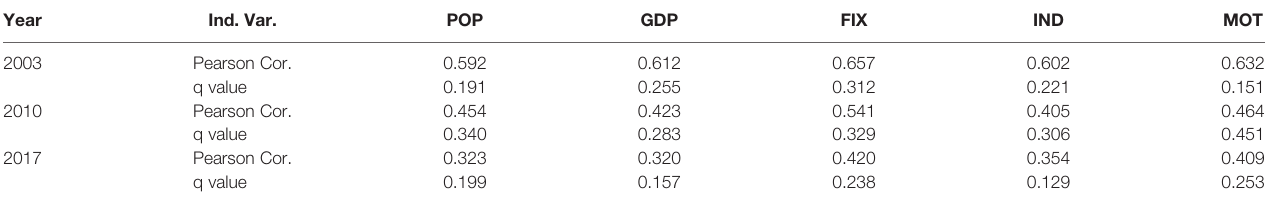
TABLE 3 | Results of Pearson correlation coef fi cient and factor detector. Year Ind. Var. POP FIX IND MOT 2003 Pearson Cor.